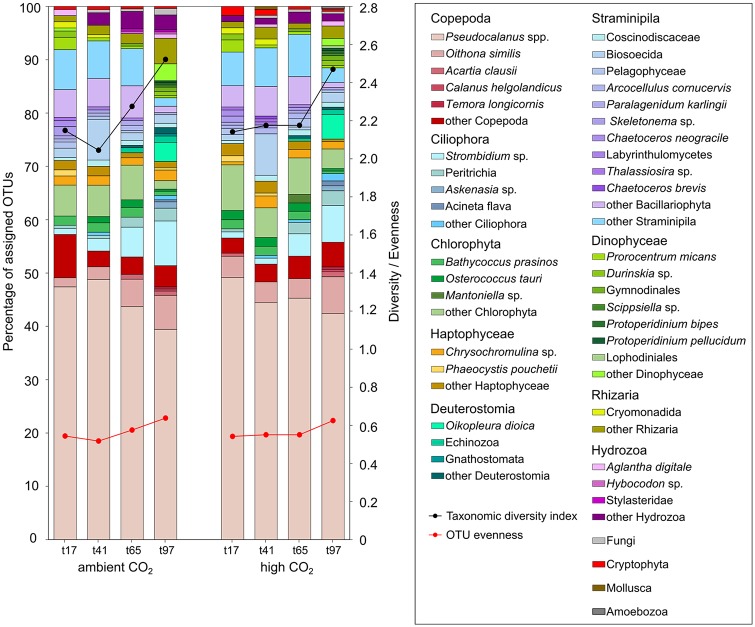
Taxonomic composition in the mesocosms.Results based on BLAST searches and MEGAN analyses of the 18S sequences. Left side ambient CO2 mesocosms (M1, M5, M9), right side high CO2 mesocosms (M2, M4, M6). Time points (t17, t41, t65, t97). The left y axis shows the percentage of assigned OTUs per taxon. The right y axis shows the taxonomic diversity index (black line) and OTU evenness (red line). Data pooled from N = 3 replicates.